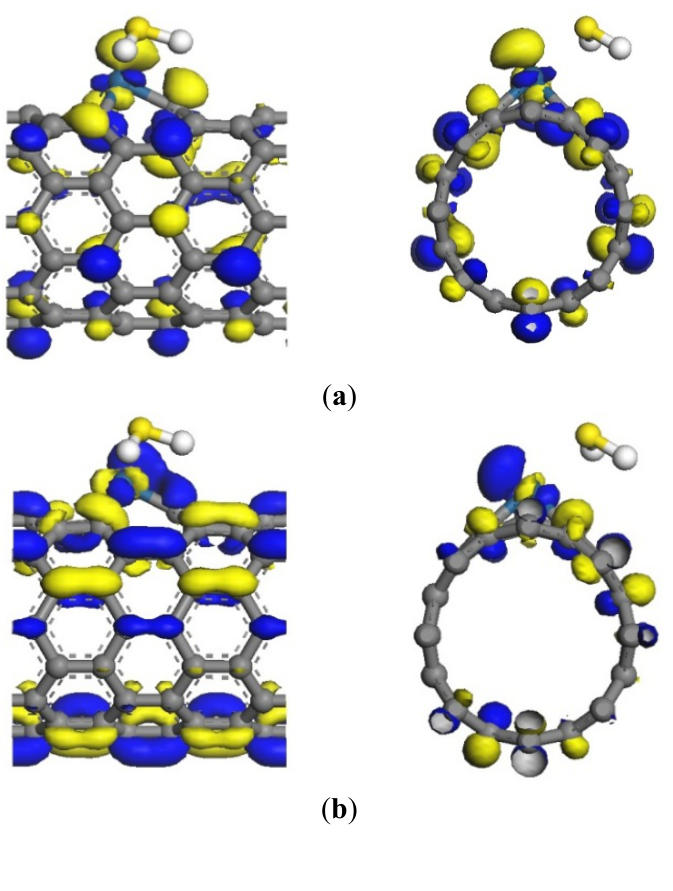
Figure 7. Frontier orbital energy level of H ( b ) LUMO (–4.142